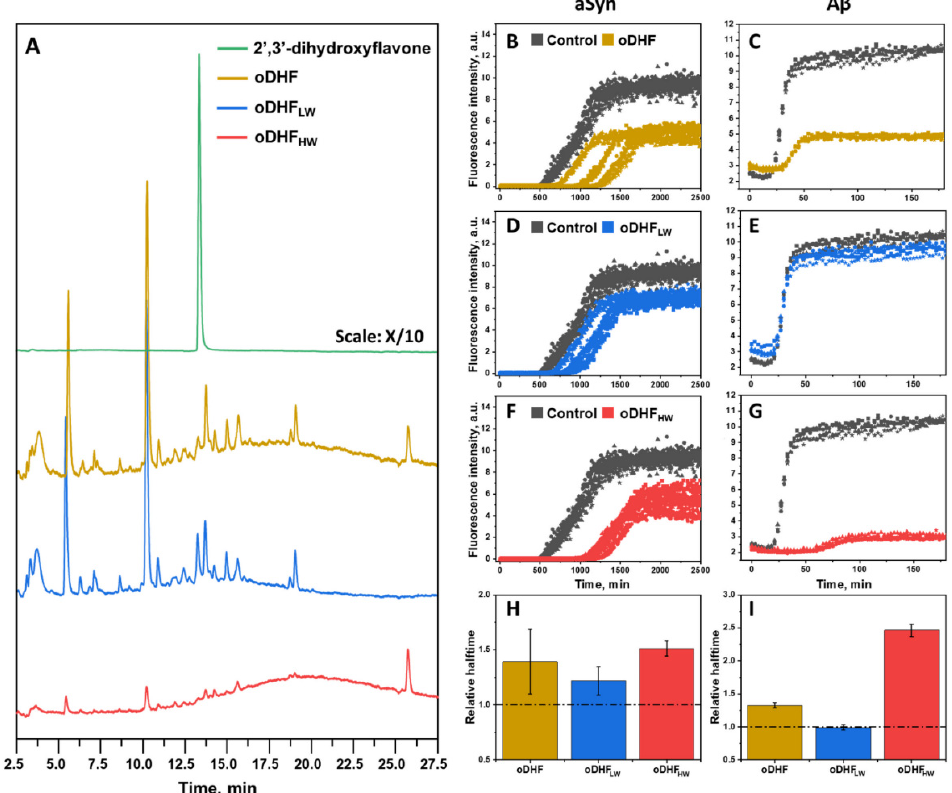
Figure 1. Chromatographic separation of 2 ′ ,3 ′ -dihydroxyflavone, oDHF and oDHF fractions (oDHF LW and oDHF HW ) ( A ). aSyn (100 µM) ( B , D , F ) and A β (1 µM) ( C , E , G ) aggregation kinetics in the presence of oDHF, oDHF LW and oDHF HW (20% for aSyn and 10% for A β experiments) and their respective relative halftime values ( H , I ). The relative halftime values were calculated based on the control sample and error bars are one standard deviation (n = 3).